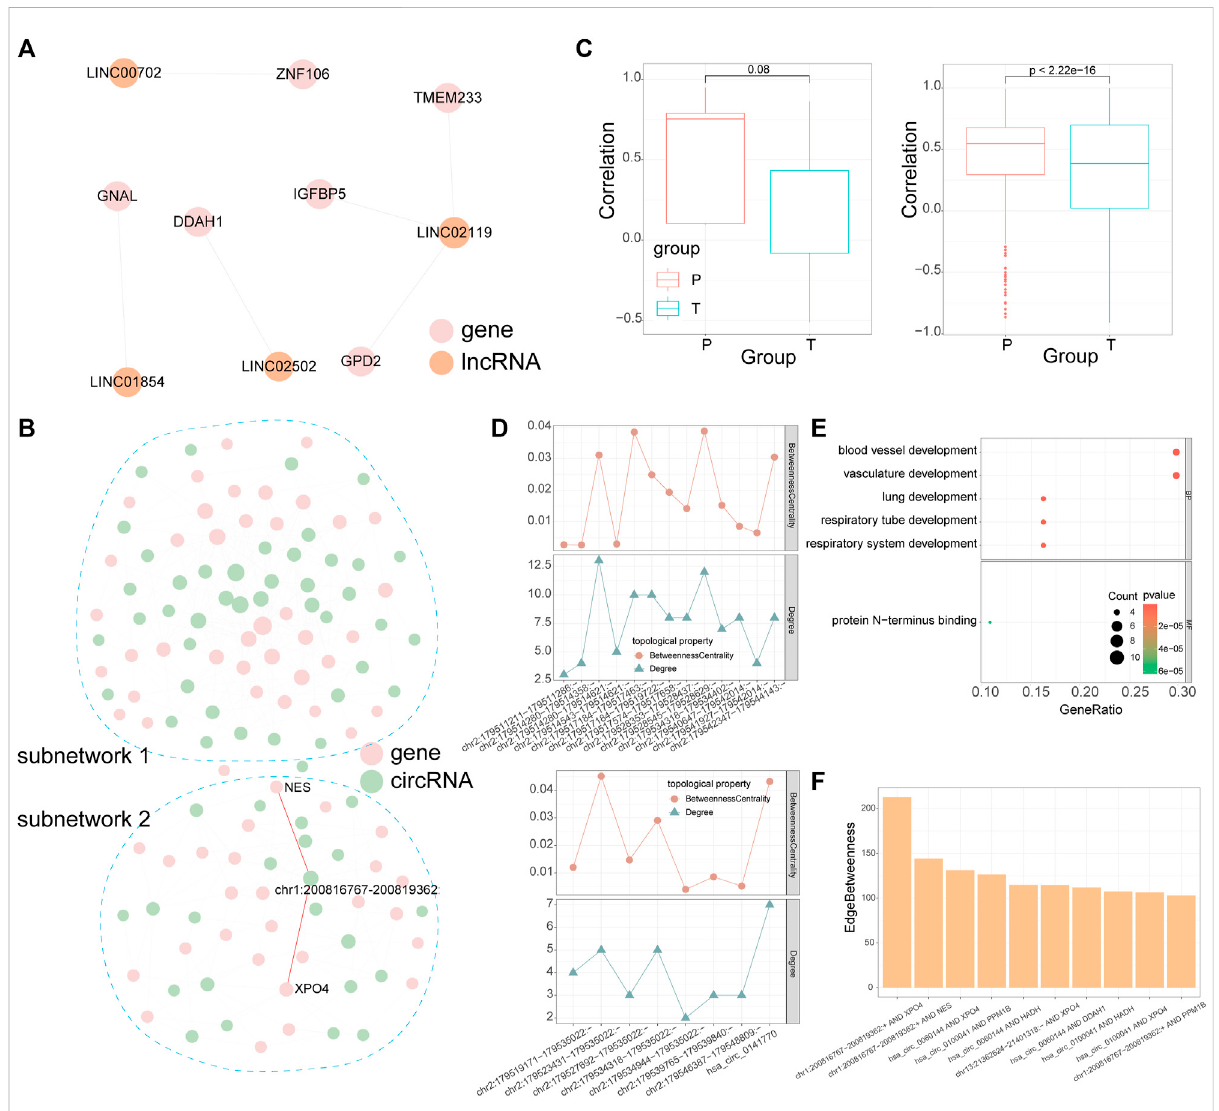
FIGURE 4 CeRNA networks of lncRNA and circRNA. (A) The dysregulated ceRNA network of lncRNAs. The size of the node represents the node ’ s degree. (B) The dysregulated ceRNA network of circRNAs. CircRNA-mRNA pairs with the highest edge betweenness are highlighted in red. (C) Pearson correlation coef fi cient between lncRNA/circRNA-mRNA pairs in the dysregulated ceRNA networks of lncRNAs (left panel) or circRNAs (right panel). (D) Line chart denotes the degree and betweenness centrality of mRNAs regulated by circRNAs which were produced by TTN in subnetwork 1 (top panel) and subnetwork 2 (bottom panel). (E) GO enrichment analysis for mRNAs in subnetwork 1. (F) Edge betweenness centrality of circRNA- mRNA pairs in subnetwork 2, only the top 10 are shown in the diagram. In the dysregulated ceRNA network, pink points denote mRNAs, orange points denote lncRNAs and green points denote